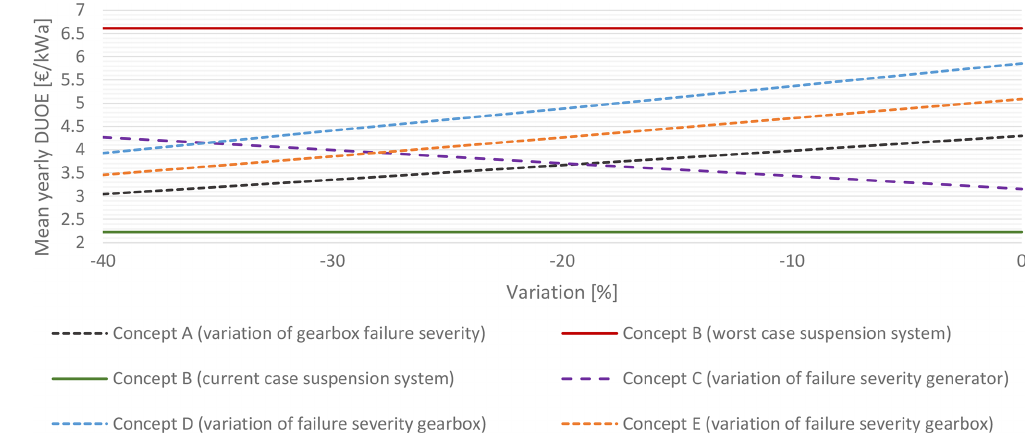
Figure 7. Impact of future development on the yearly mean DUOE for a 5MW 150m rotor diameter onshore